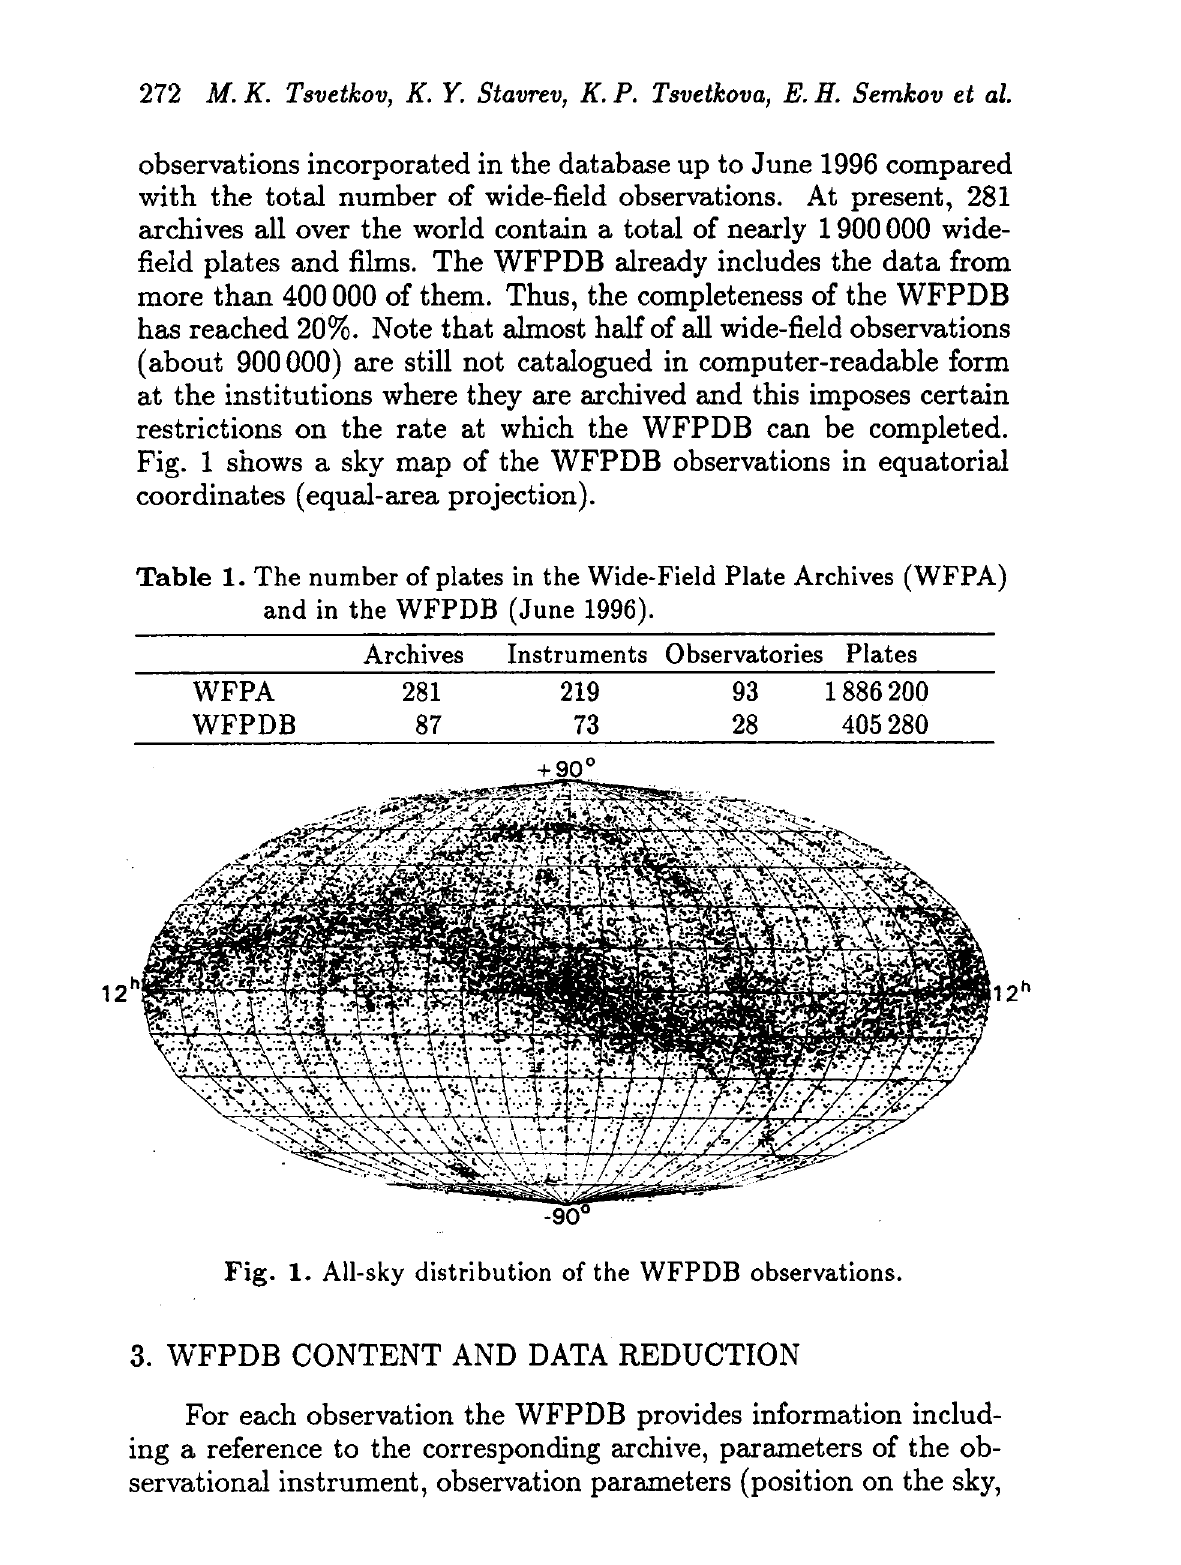
Fig. 1. All-sky distribution of the WFPDB